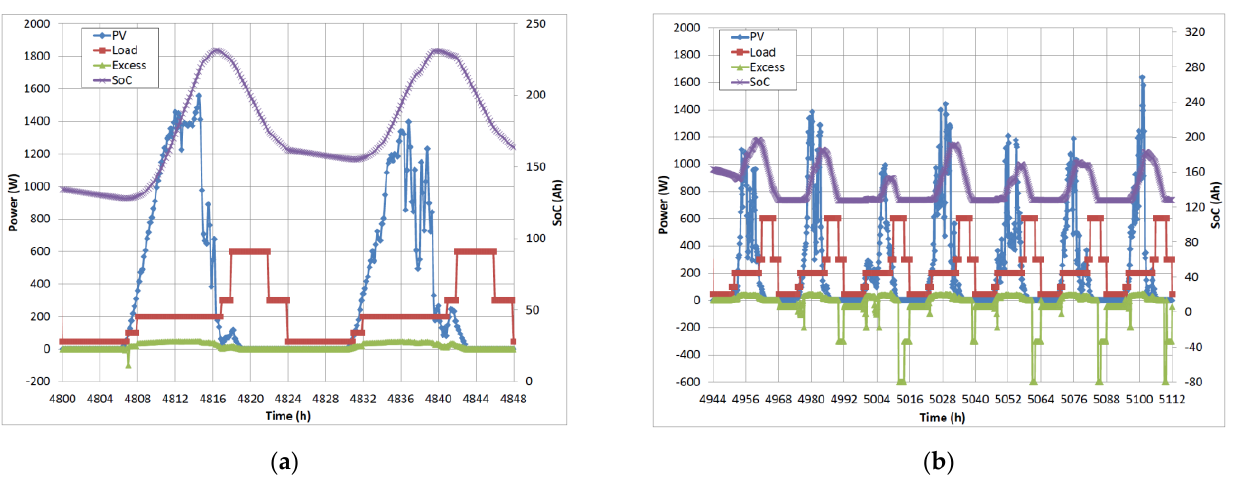
Figure 9. Results of analysis with ten-minute solar data: ( a ) days 19 – 20 July 2019 and ( b ) week 25 – 31 July 2019.